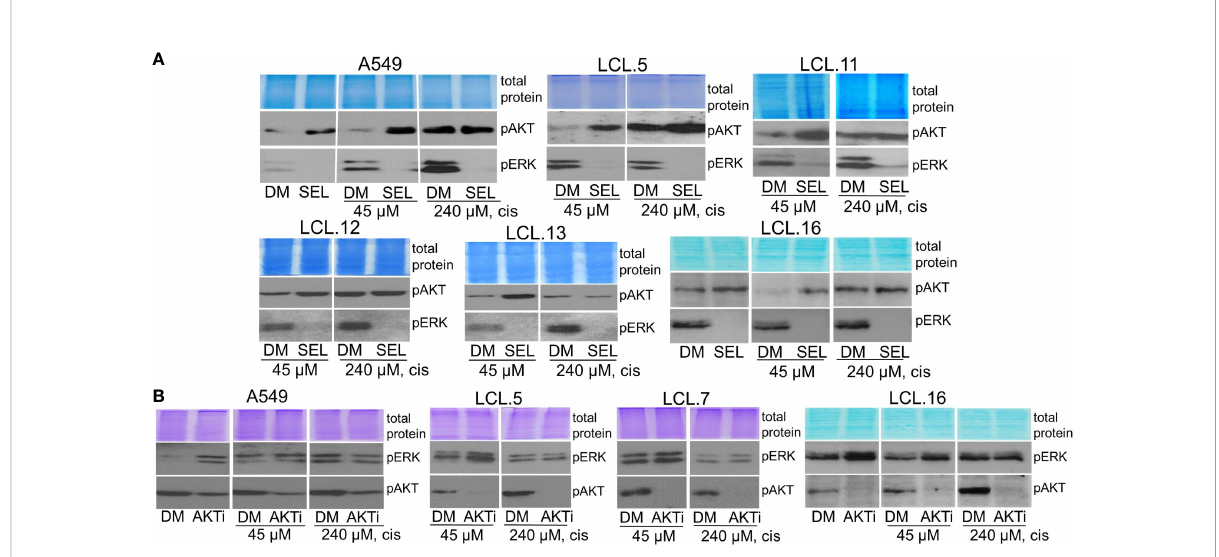
FIGURE 9 ERK and AKT crosstalk might be signal strength-dependent. Cells pretreated with a high concentration of cisplatin (240 µM) do not show alternative kinase AKT activation in response to ERK inhibition by selumetinib (A) , nor ERK activation in response to AKT inhibitor VIII, contrary to untreated or low cisplatin concentration (45 µM)-treated cells (B) . Representative Western blots are shown. Coomassie-stained protein gels are presented as loading controls. 6-hour-long exposures to the drugs were used. DM – vehicle control (DMSO), SEL – selumetinib (10 µM), cis - cisplatin, AKTi – AKT inhibitor VIII (10